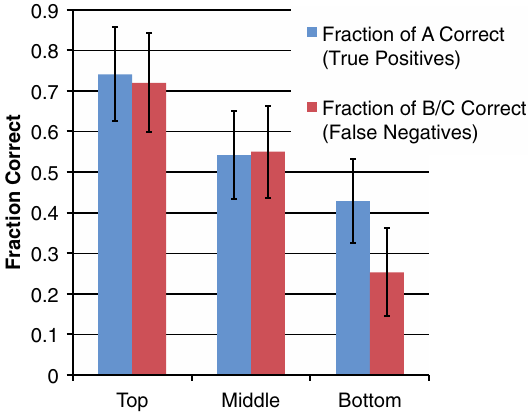
FIG. 4. Average fraction of KS questions to which students had responded A or B or C which they then went on to answer correctly, broken out by student groupings based on overall final exam score for Physics 211. Error bars represent the 95% confidence interval of the mean.